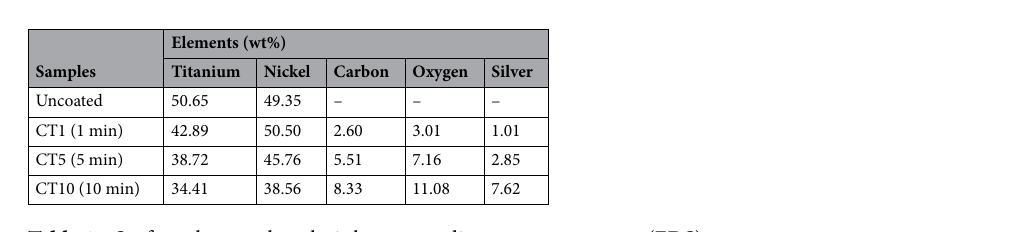
Table 1. Surface elemental analysis by energy disperse spectroscopy